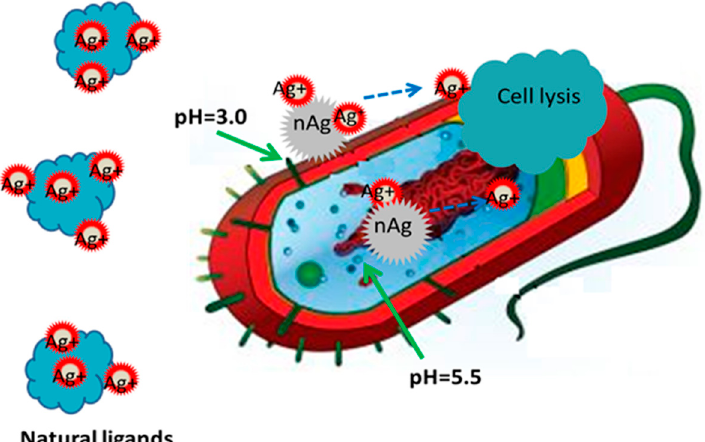
Figure 4. Ag NPs function as vehicles to deliver Ag ions to interact with bacterial cytoplasm and membrane, decreasing the local pH. Reproduced with permission from Reference [61]. Copyright 2012, American Chemical Society.